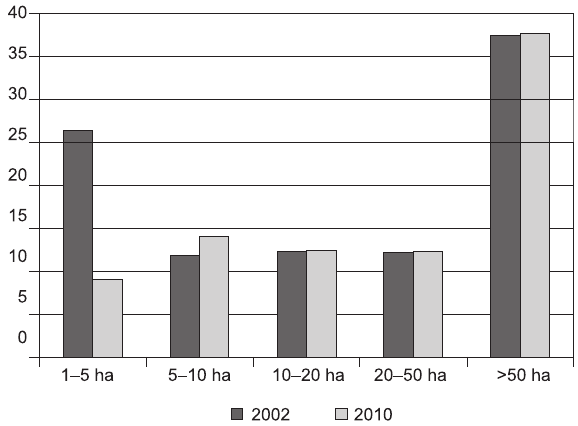
Fig. 5. Changes in the share of farms (of more than 1 ha) in the particular size groups in Germany in 2002 and 2010 (%) Source: authors’ own calculation based on German 2011 data and Polish 2002 and 2010 Agricultural